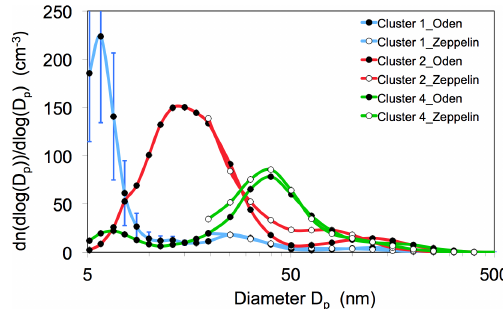
Figure 11. Average number size distributions in three clusters of harmonized size distribution data taken on Oden and on Mt. Zep- pelin during the Oden cruises in the summers of 2001 and 2008. There are no Mt. Zeppelin data below 20nm diameter. For cluster 1, standard deviations about the average Oden data are